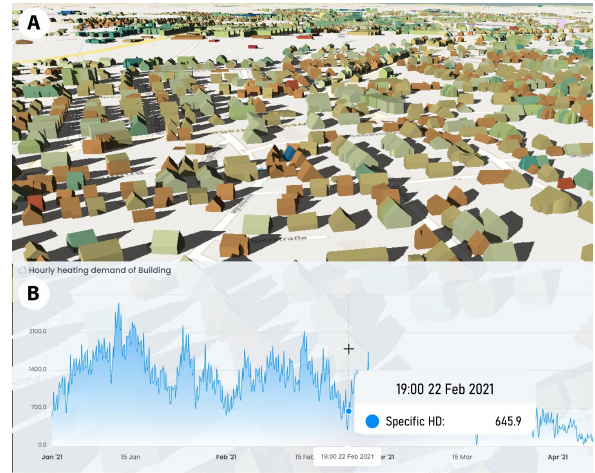
Figure 8. A visualization in the EnSysLE UDT application illustrating A: 3D city models styled according to the calculated specific space heating demand (kWh/m 2 /yr), B: the pop-up window showing hourly heating demand (kW) of the selected building.